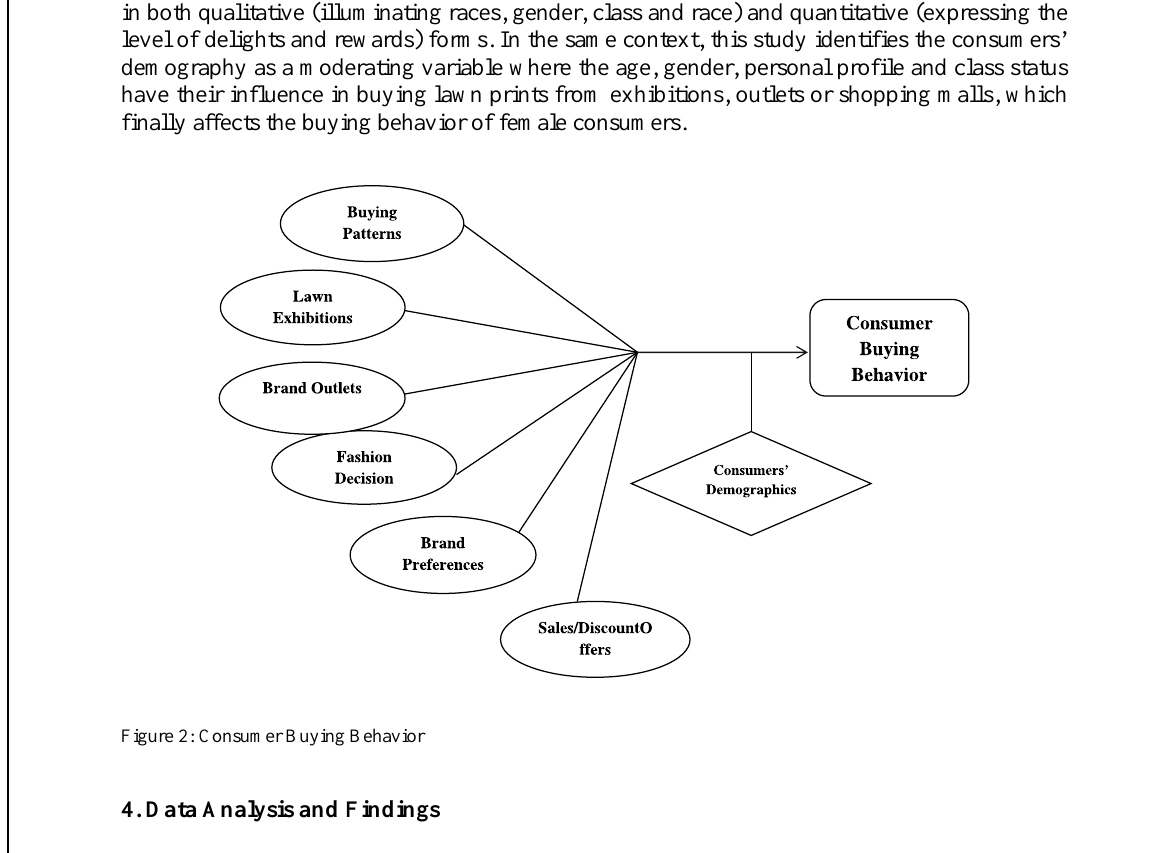
Figure 2: Consumer Buying